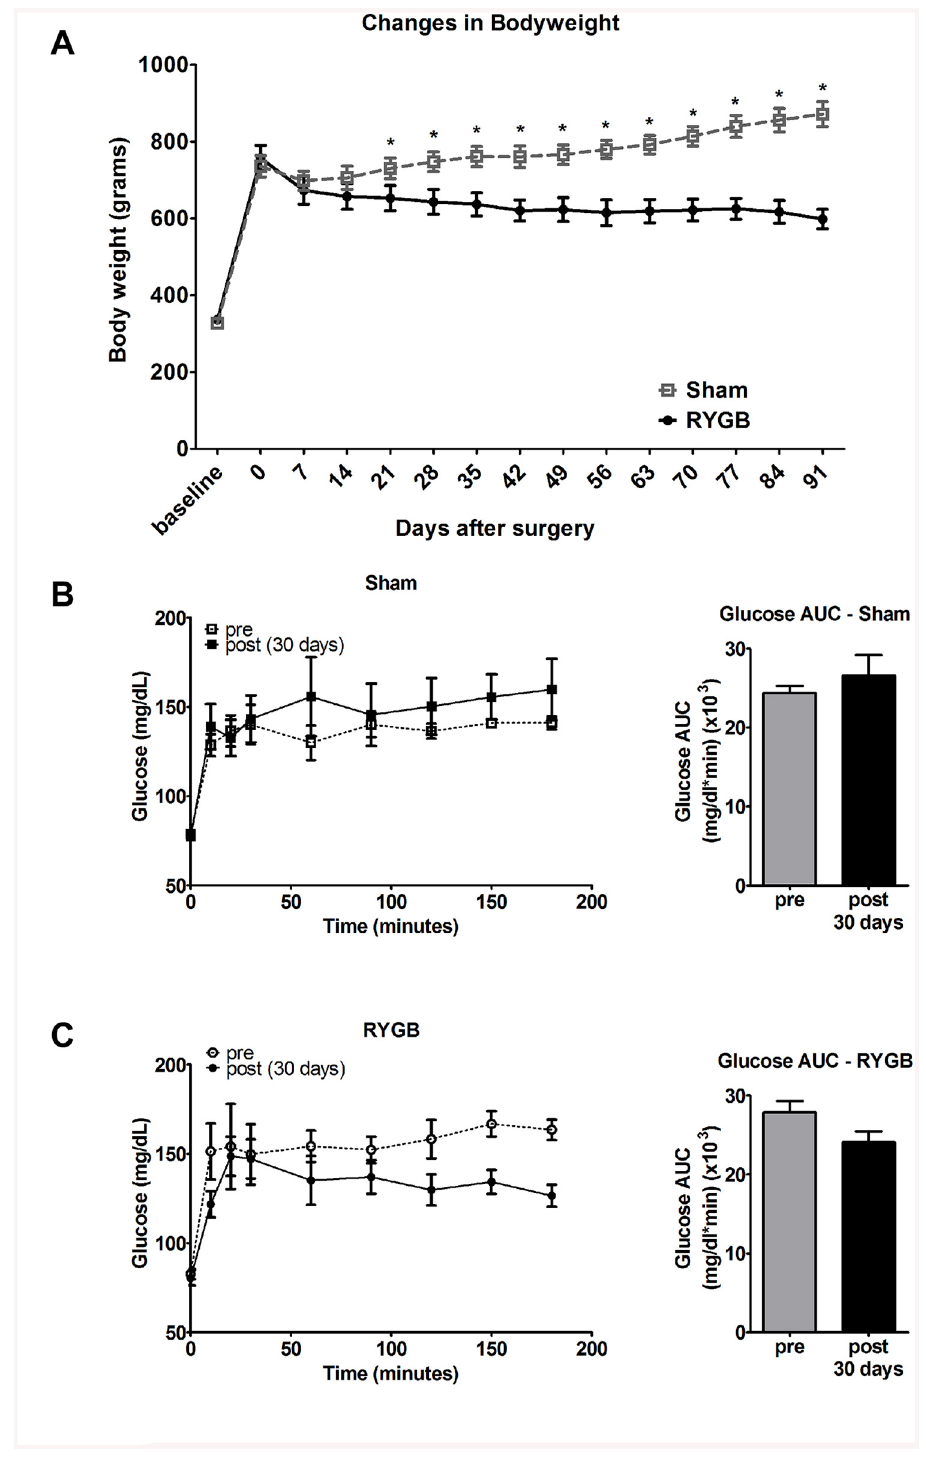
Fig 1. RYGB surgery improves body weight (A) and glycemic control (B) for up to 90 days in SD rats fed a high fat diet. (A) Records of body weight for Sham control vs RYGB animals. (B and C) Plasma Glucose response (left) and glucose AUC (right) during OGTT for Sham (B) and RYGB (C), before (gray) and after (black) surgery. Data are mean ± SE, asterisk sign denotes a significant difference between Sham control vs. RYGB with P <